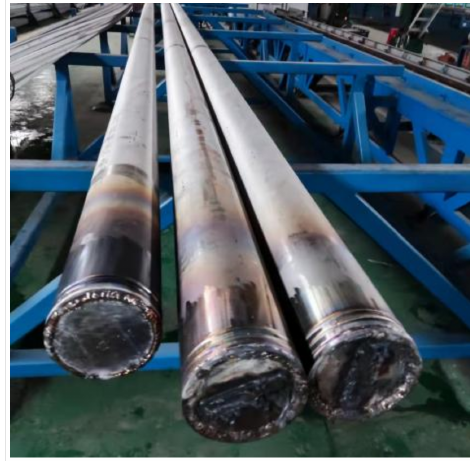
Figure 3. Schematic of the composite billet.